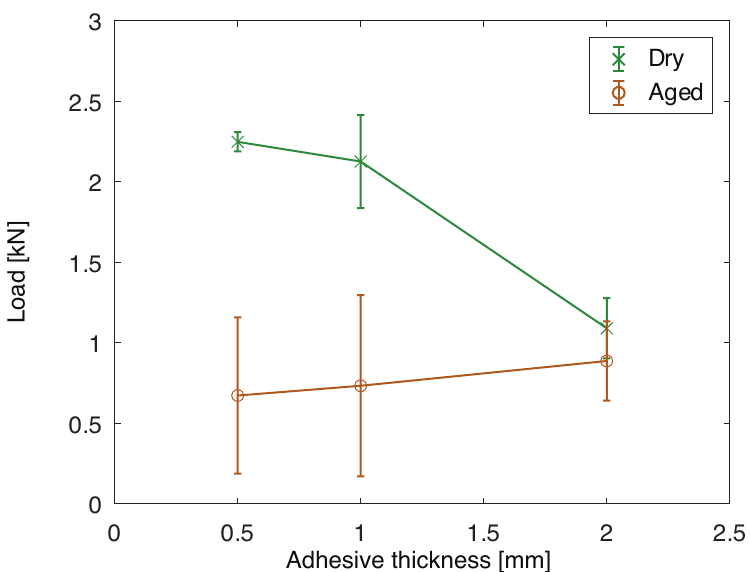
Figure 17. Maximum load for single lap joint tests for joints with aluminum substrates as a function of the adhesive thickness, dry and after aging at 70 ◦ C for two months.